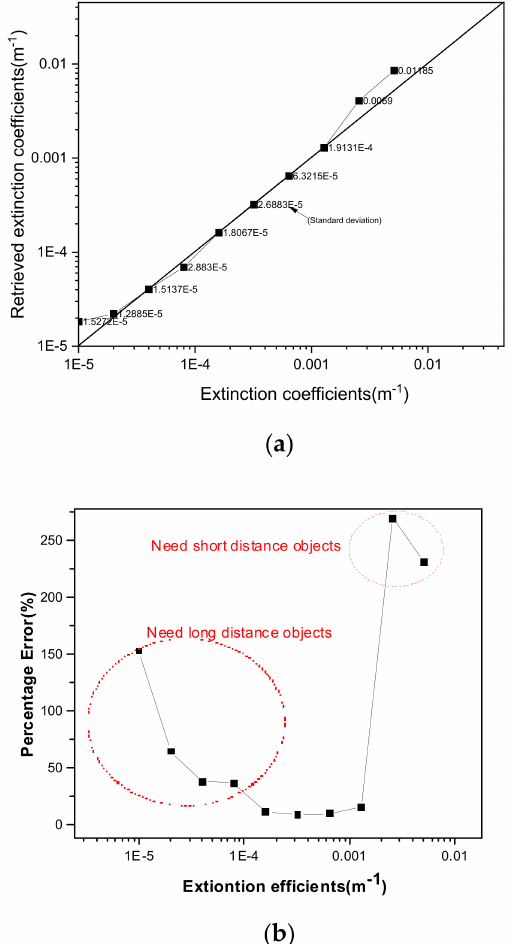
Figure 8. ( a ) The retrieved aerosol extinction coefficients and assumed aerosol extinction coefficients when object-refection and aerosol scattering coefficients change randomly within 10%. ( b ) The per- centage errors of the retrieved extinction coefficients for the same target distances (438 m, 1200 m, 2400 m, 3400